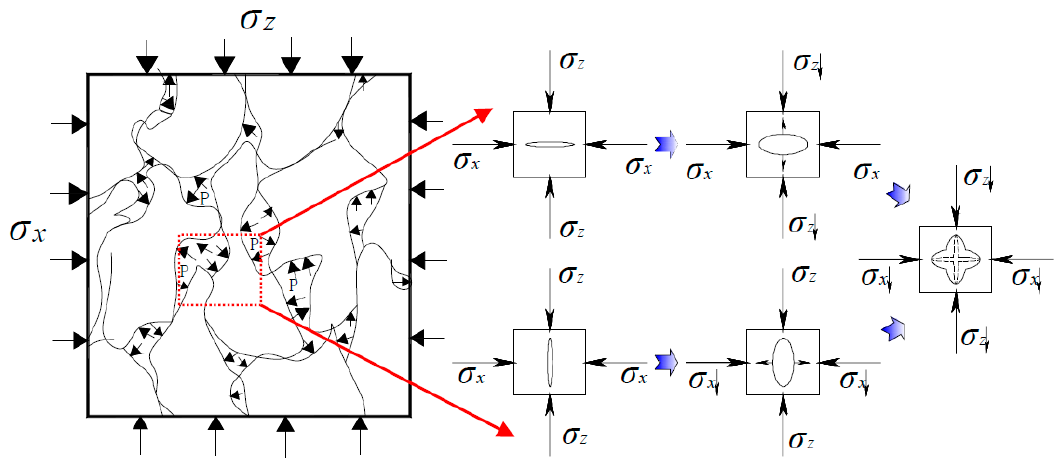
Figure 3. Relationship between pressure relief and fracture expansion.